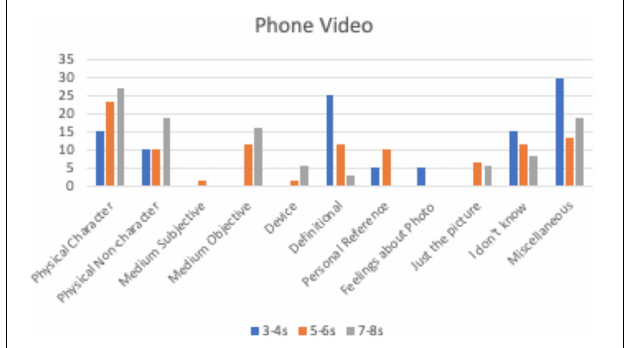
FIGURE 4 | Percentage of children by age group providing each justification for the phone video.